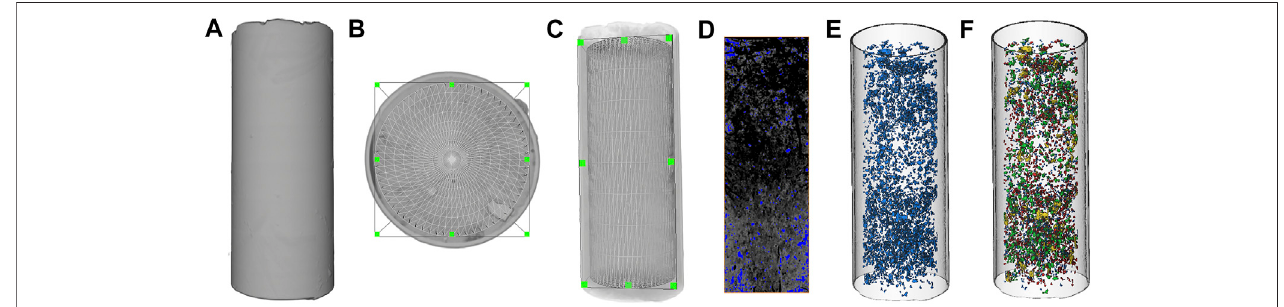
FIGURE 2 | Process steps of the scanned images of the soil columns using Avizo 9.0 software: 3D imaging of the original soil column (A) , top view (B) and lateral view (C) oftheregionofinterest(ROI)(cylinder),cross-sectionofinteractivethresholdingsegmentation(blueindicatestheselectedrockfragment) (D) ,3Dreconstruction of the rock fragment network (E) , and assignment of different colors for the different equivalent diameter grades of the rock fragments (F) .